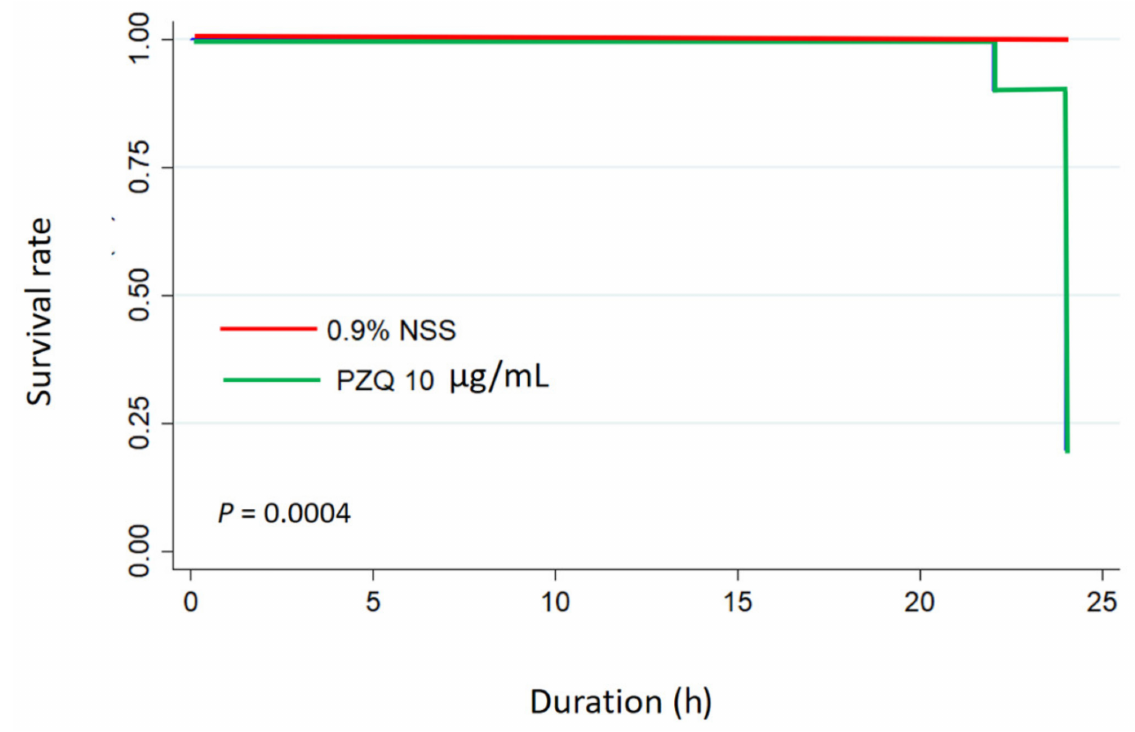
Figure 2. The parasiticidal activity of PZQ on time-killing in P. gralli . The parasites were exposed to PZQ 10 µ g/mL and 0.9%NSS (control). Kaplan–Meier plot represents survival rate in two different groups ( n = 10 per group). The Log Rank test was used for statistical